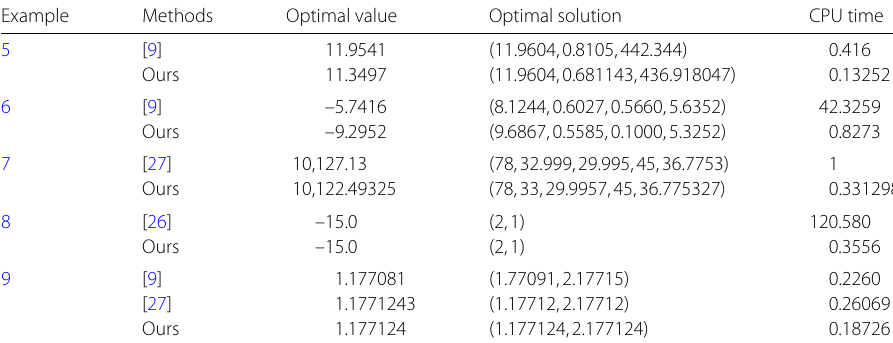
Table 2 Results of the numerical comparison of Examples 5–9